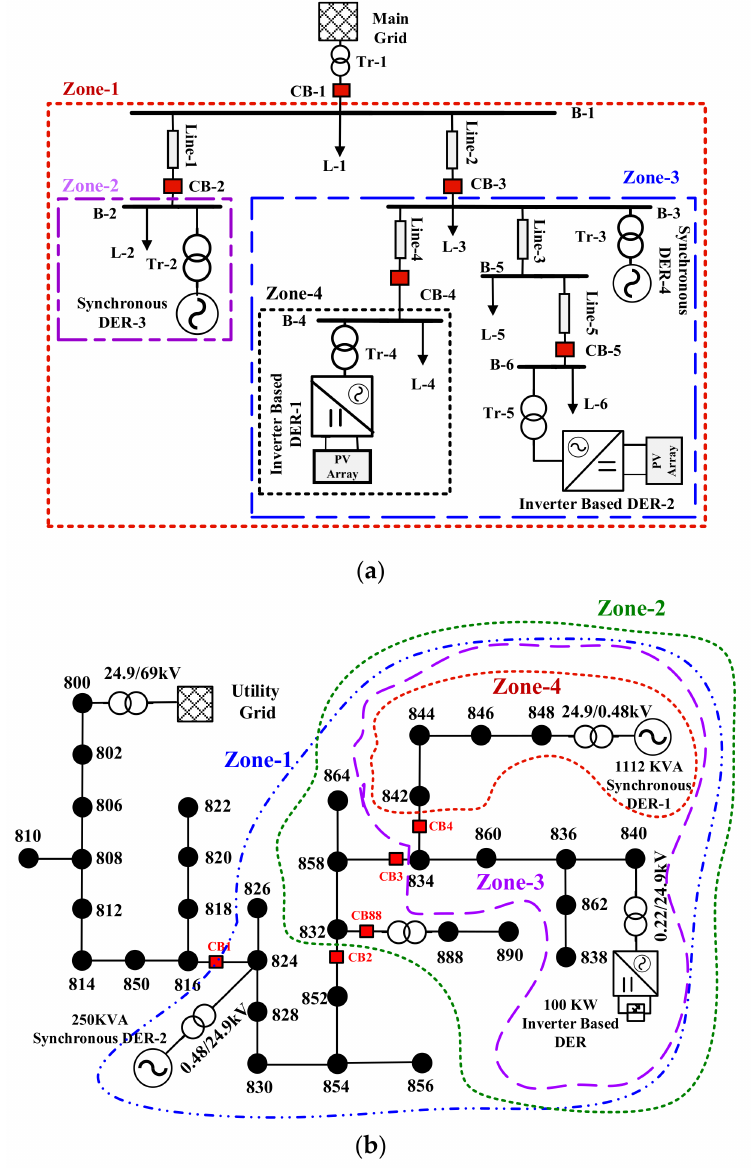
Figure 4. Test systems considered in this study: ( a ) IEC Microgrid. ( b ) Modified IEEE-34 node test